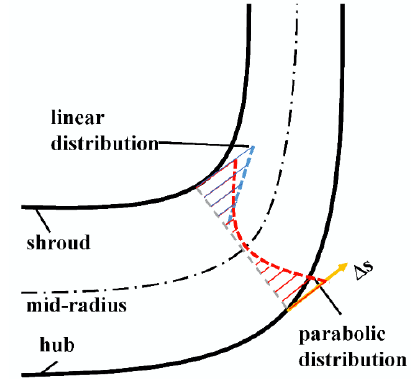
Figure 1. Spanwise loss distributions.